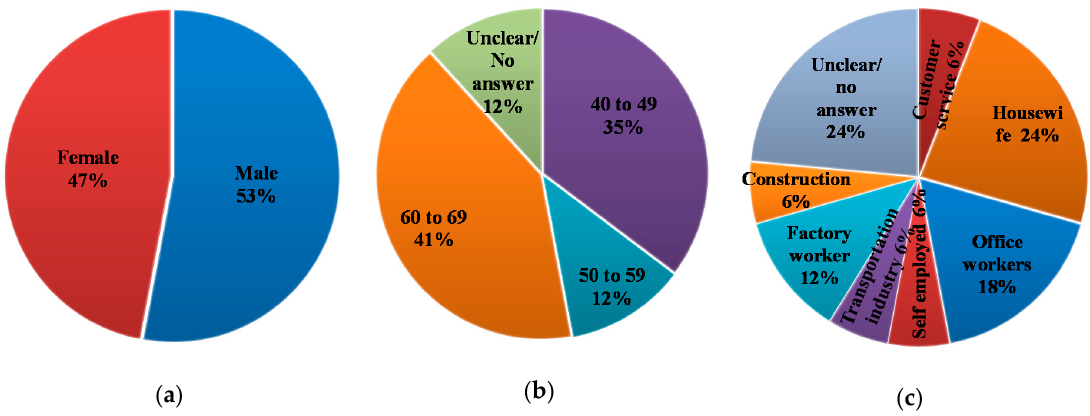
Figure 3. Distribution of respondents; ( a ) Gender distribution of respondents (n = 17); ( b ) Age distribution of respondents (n = 17); ( c ) Occupation of respondents (n = 17).